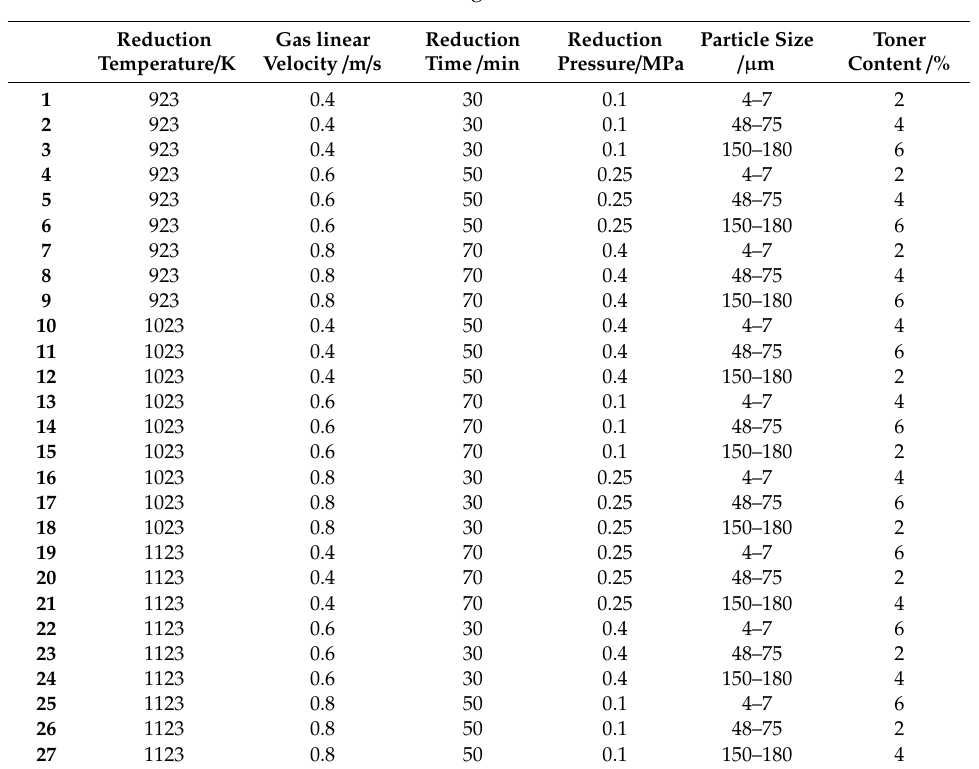
Table 5. Orthogonal test